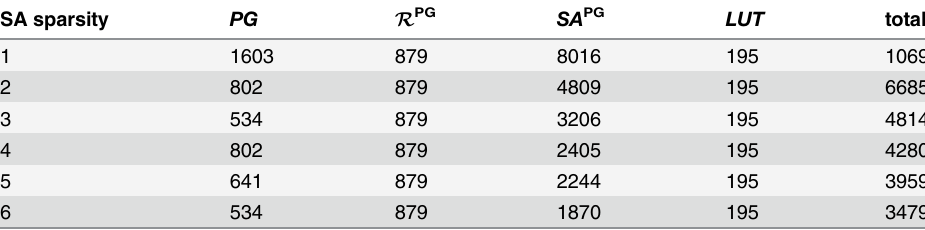
Table 4. C. elegans dataset, space consumption. All sizes in megabytes.